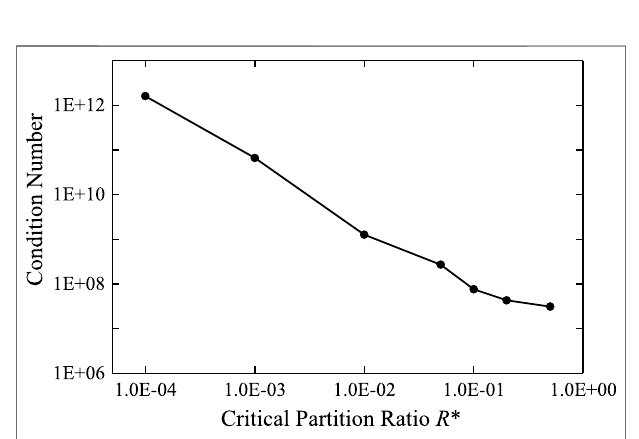
FIGURE 17 | Relationship of Jacobian condition numbers using the mixed scheme with critical partition ratios.